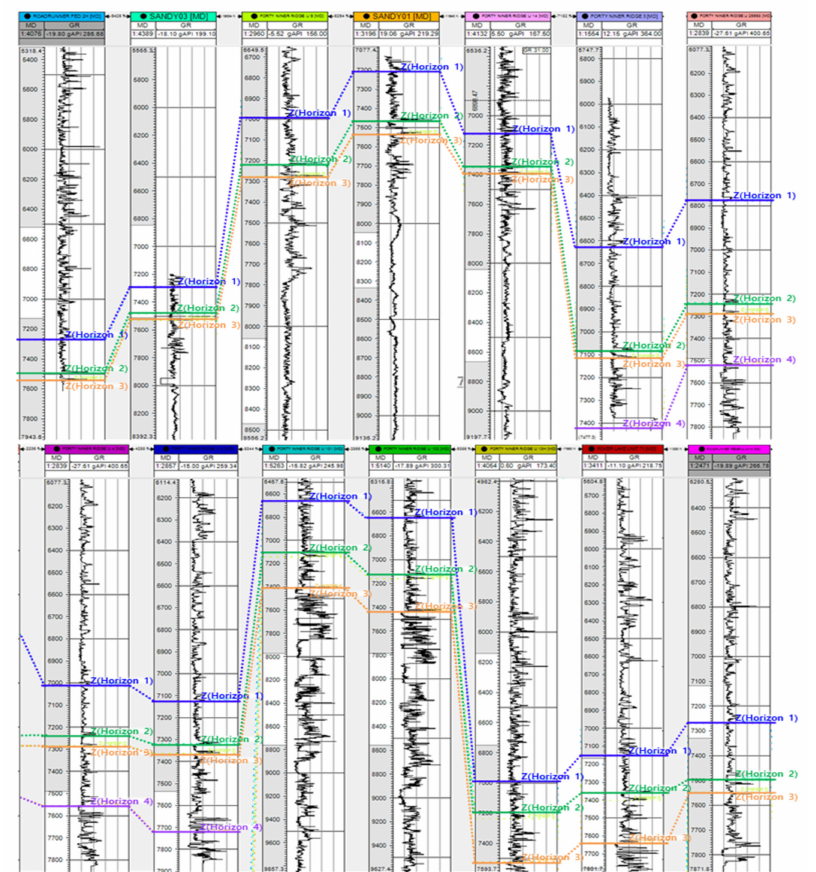
Figure 1. The layer formation process of the reservoir by connecting the similar trends in the gamma ray logs obtained from 17